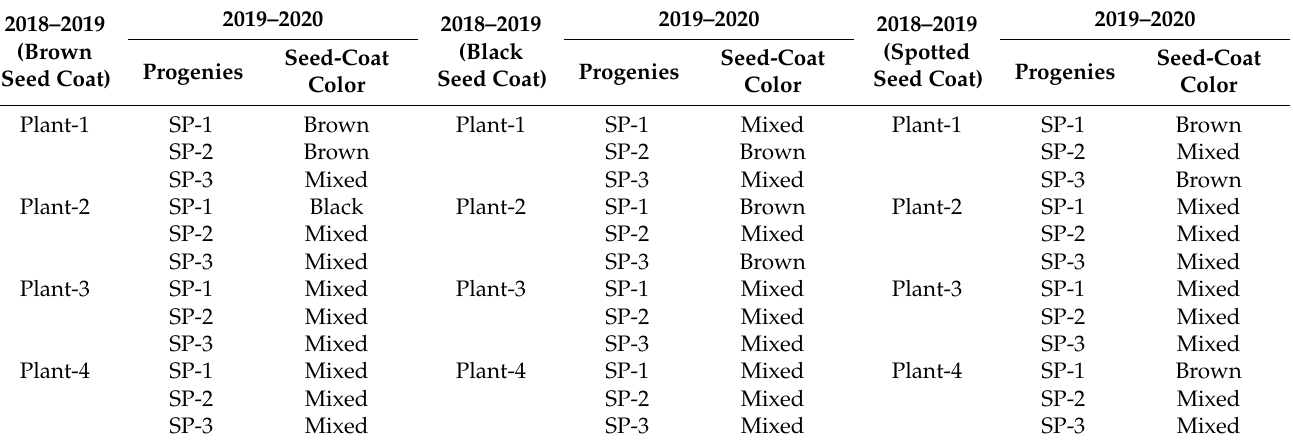
Table 2. Details of seed-coat color expression in 12 plants (2019–2020) each, derived from brown, black, and spotted seed-coat categories (2018–2019) from L4717-NM